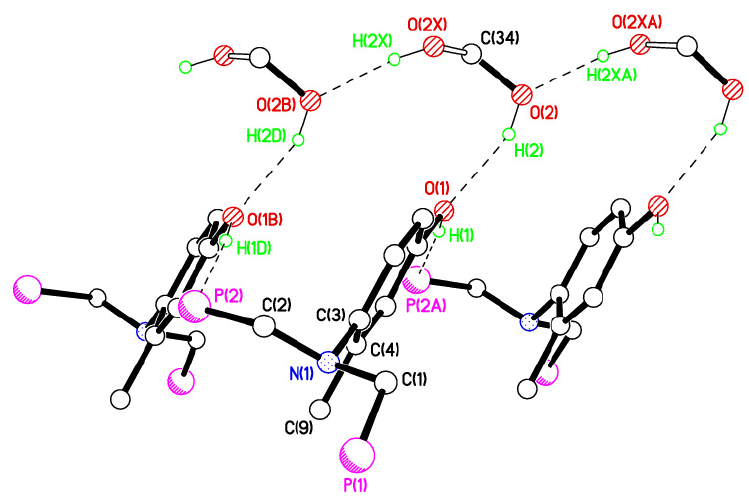
Figure 3. Crystal structure packing plot for 1b · CH 3 OH. Most H atoms, two Ph groups per P atom have been omitted for clarity. Symmetry code: A = x, − y + ½, z + ½.